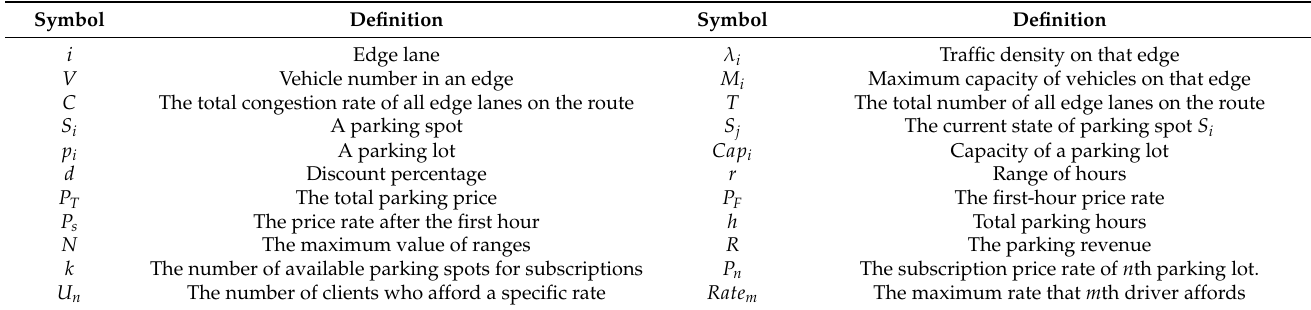
Table 2. List of